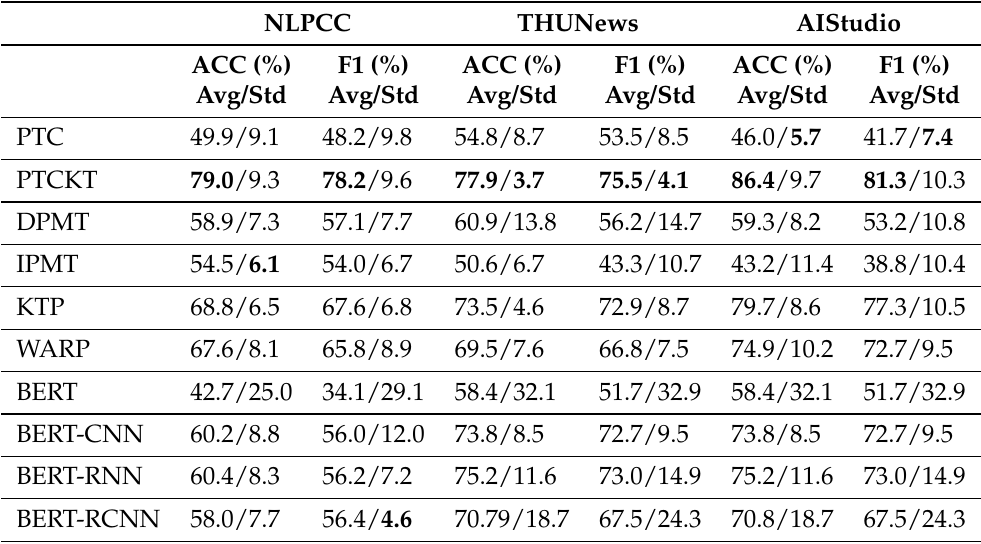
Table 2. Average (Avg) and standard deviation scores (Std) of the accuracy and F1 for all the methods in the few-shot setting (K = 2) on different datasets. Bold stands for the best.